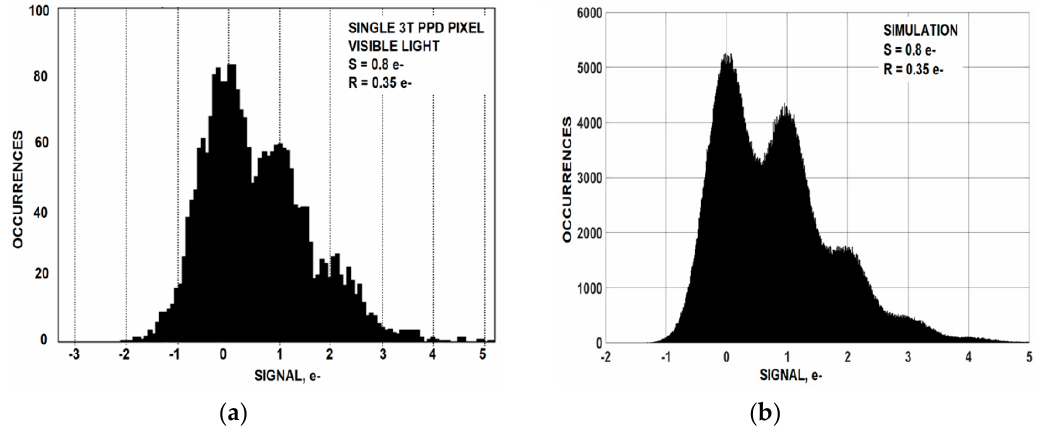
Figure 5. Experimental ( a ) and simulated ( b ) histograms for a low noise 3T PPD CMOS pixel showing a Poisson distribution profile. Read noise for this pixel is 0.35 e − rms.